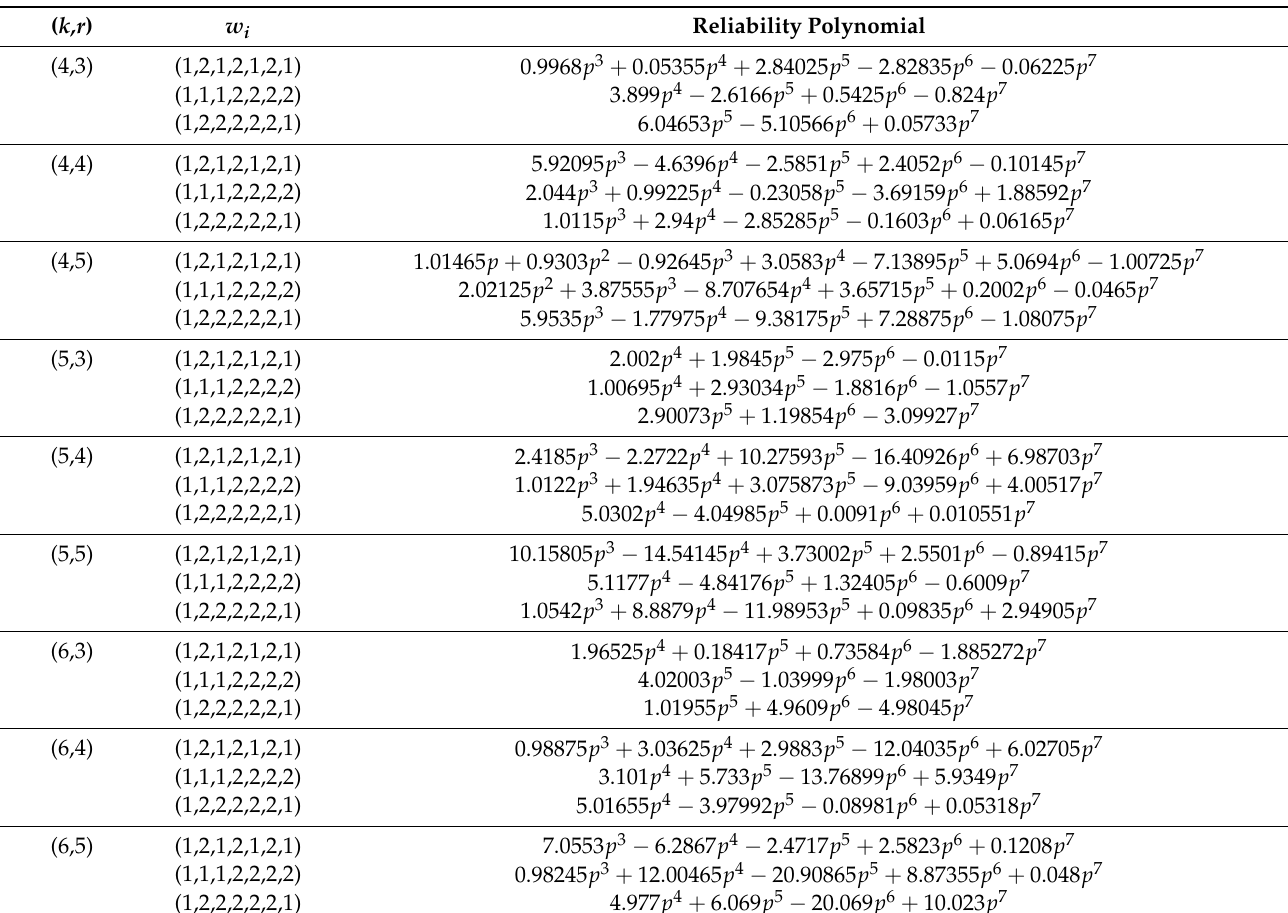
Table 7. Reliability polynomials of weighted- r -within-consecutive- k -out-of- n : F structures of order n =